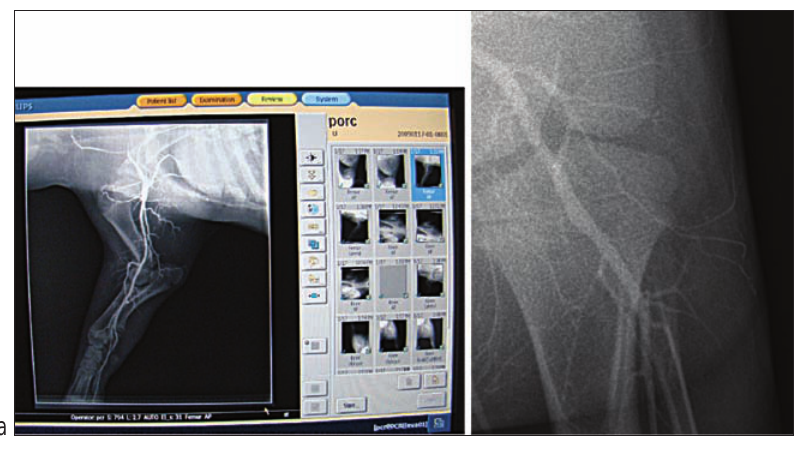
Fig. 3. Digital angiography: (a) anterior limb, (b) posterior limb (enhanced) These data were correlated with the ones obtained through minute surgical disection.